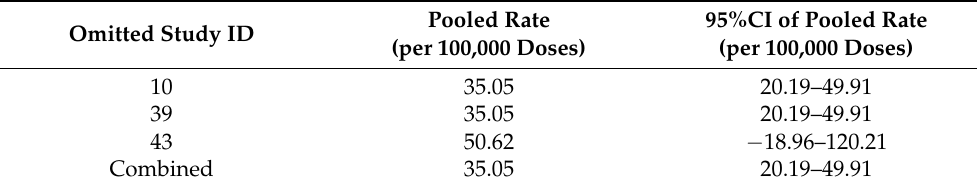
Table A4. Sensitivity analysis of SAEs of viral vector vaccines of surveillance studies.